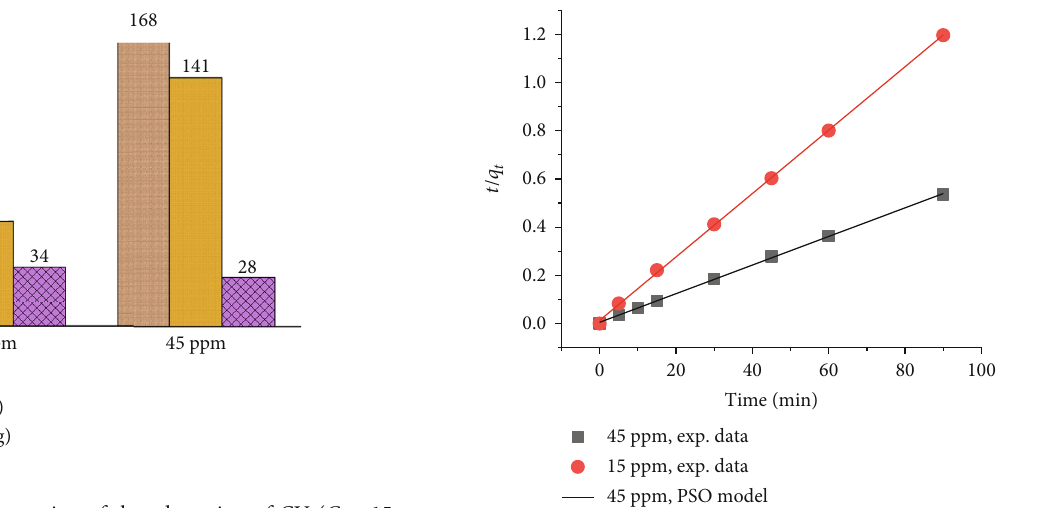
= 15 0 , the initial adsorption 5 t Figure 6: PSO kinetic plot for the adsorption of CV onto PACK. ), along with e ffi ciency (%) values. e